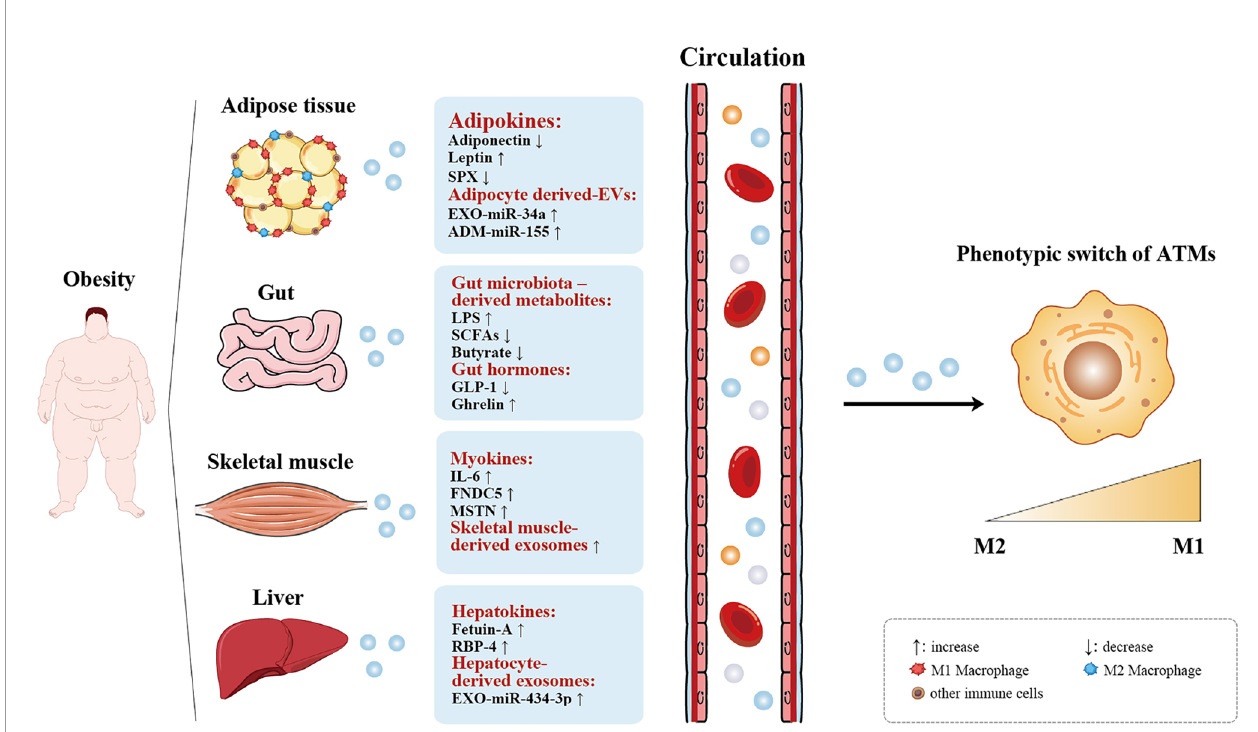
FIGURE 1 | Organokines and exosomes-mediated ATM polarization. Adipose tissue, gut, skeletal muscle, and the liver act as endocrine organs by secreting organokines (adipokines, gut microbiota-derived metabolites, gut hormones, myokines, and hepatokines) and exoxomes (adipocyte-, skeletal muscle-, and hepatocyte-derived exosomes), which are increased or decreased in obesity, thus affecting the phenotype of ATMs switch from the anti-infammatory (M2) state to the pro-infammatory (M1) state. ↑ increase, ↓